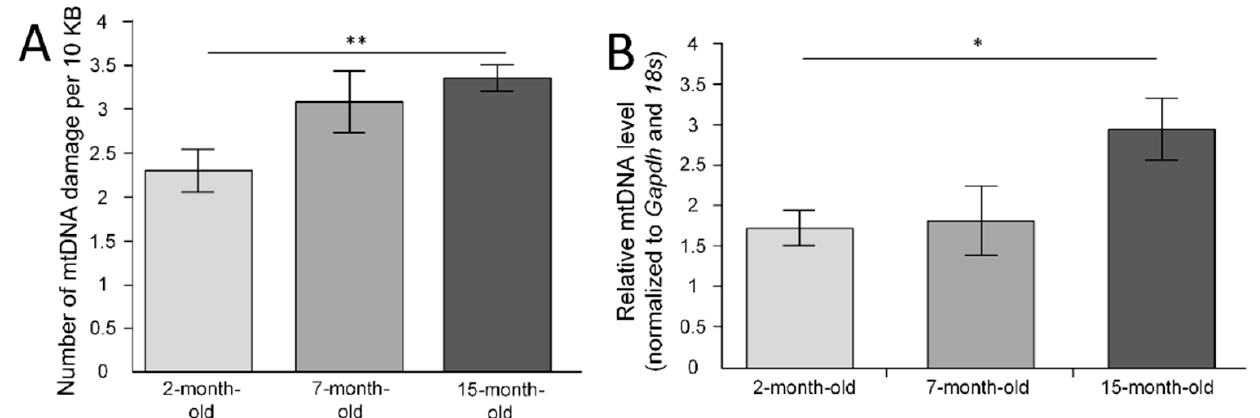
Figure 1. The age-related changes in mtDNA in the cerebral cortex in the three age groups of mice. ( A ) The mean number of damages through all studied fragments of mtDNA. ( B ) Normalized mtDNA level in the frontal cortex * p < 0.05, ** p < 0.01 differences between age groups were statistically significant according to the Mann–Whitney test. The 2-month-old mice (n = 9), 7-month-old mice (n = 9), 15-month-old mice (n = 9). There was no age-related increase in the number of mtDNA damage in the fragments encoded Nd5 gene (F(2, 24) = 2.1801, p = 0.13490) and Nd6-CytB genes (F(2, 24) = 1.1213, p = 0.34233). In the region of mtDNA, which encoded ribosomal RNA genes, there was an increase in the number of damages in the group of 7-month-old mice compared with 2-month-old mice ( p < 0.01). A similar result was obtained for the region, encoded Nd1-Nd2 genes ( p < 0.05). For 15-month-old mice, the maximal number of mtDNA damage was noted in regions encoded 16s-Nd1 genes ( p < 0.05 compared with 2-month-old mice) and RNA non-coding region D-loop ( p < 0.001 compared with 2-month-old mice and p < 0.01 compared with 7-month-old mice) (Table 1). Table 1. Number of mtDNA lesions in the cerebral cortex in the three age groups of mice. Fragment Number of mtDNA Lesions (per 10